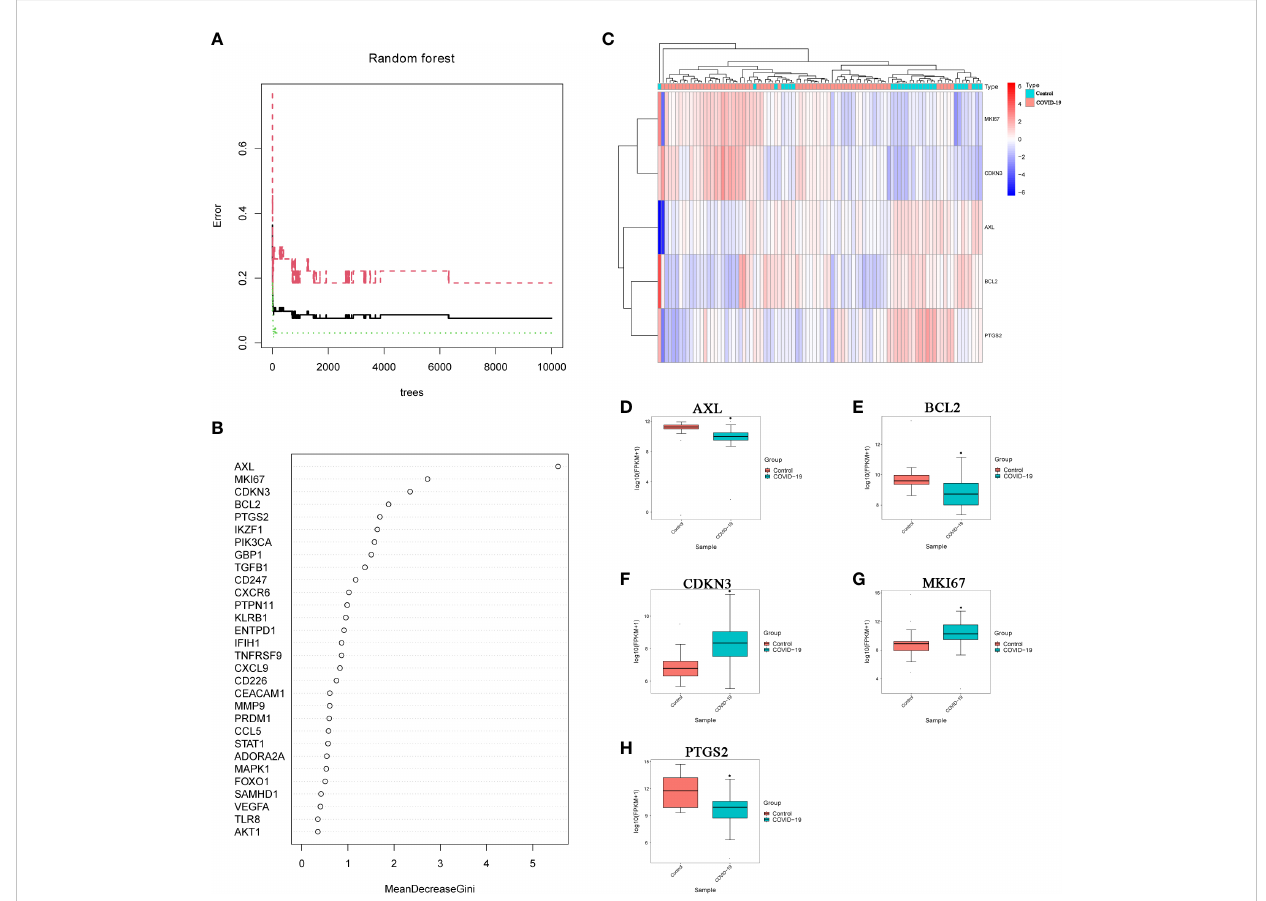
FIGURE 5 Screening important IADEGs using a random forest model. (A) Relationship between the number of decision trees and model error; x-axis, number of decision trees; y-axis, error rate of the constructed model. (B) Importance of all variables in the random forest classi fi er determined using the Gini coef fi cient method; x-axis, mean decrease of the Gini index; y-axis, variables. (C) Heatmap of k-means clustering for the GSE151764 and GSE183533 dataset. Colors in the graph from red to blue indicate the change from high to low expression levels. In the upper part of the heatmap, the blue band indicates control samples and the red band COVID-19 samples. (D – H) Differential expression of AXL, MKI67, CDKN3, BCL2 and PTGS2 the GSE151764 and GSE183533 datasets. *P<0.05, vs Control